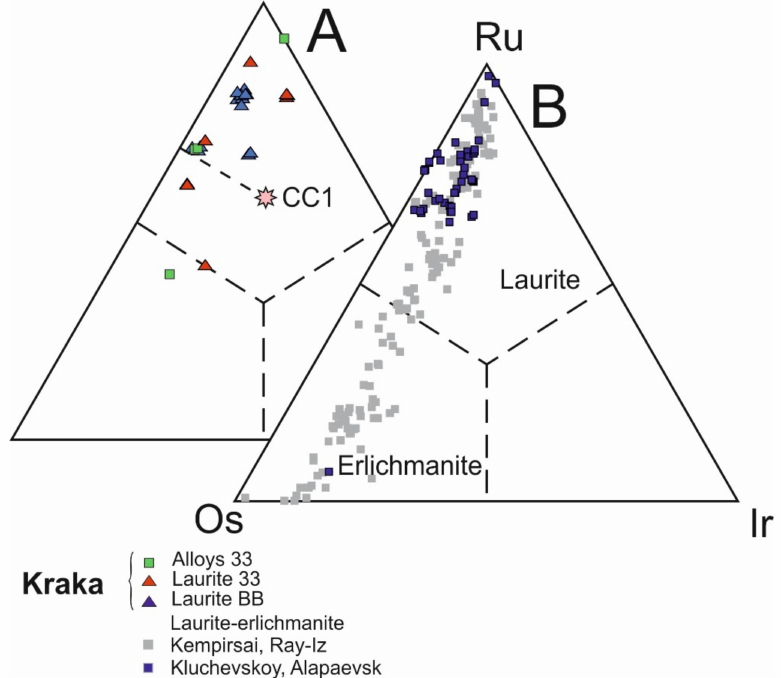
Figure 12. Compositions of laurite-erlichmanite sulfides and Ru-Os-Ir alloys from the chromite deposits of Kraka ( A ). Composition of laurite-erlichmanite sulfides from the chromite deposits of Ray-Iz, Kempirsai, gray squares; Kluchevskoy, Alapaevsk, blue squares ( B ) (data source